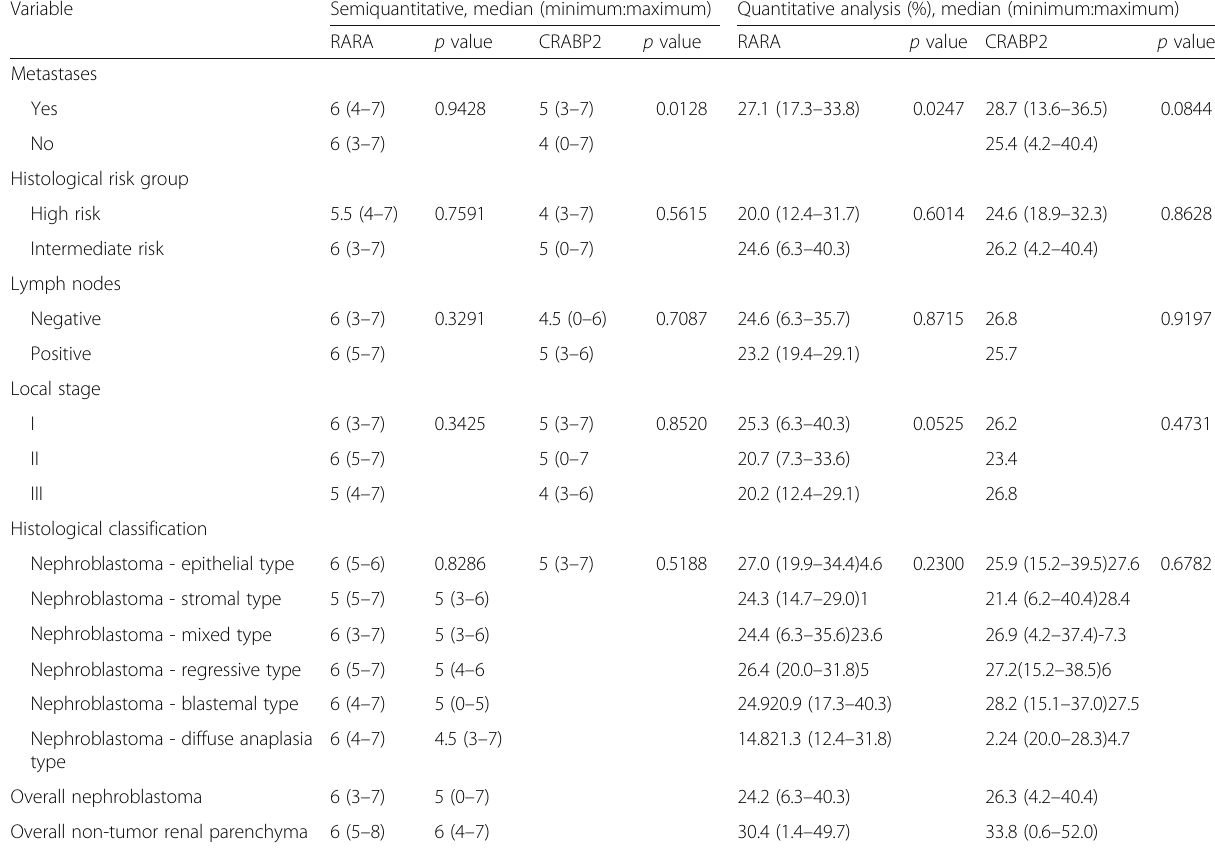
Table 2 Median immunoexpression of RARA and CRABP2 in nephroblastomas based on histological subtype